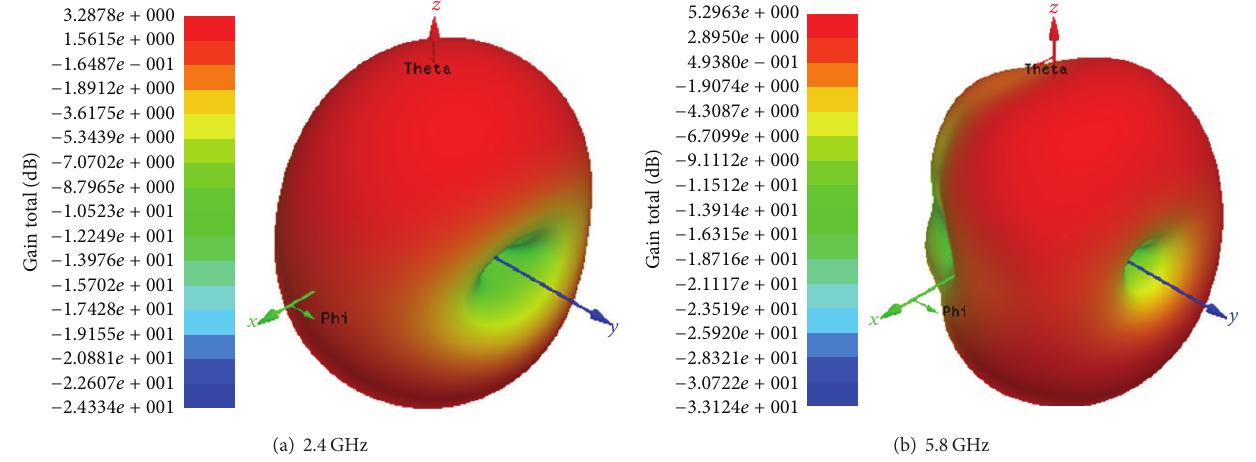
Figure 6: Simulation of the E-shaped antenna radiation patterns for the off-state.